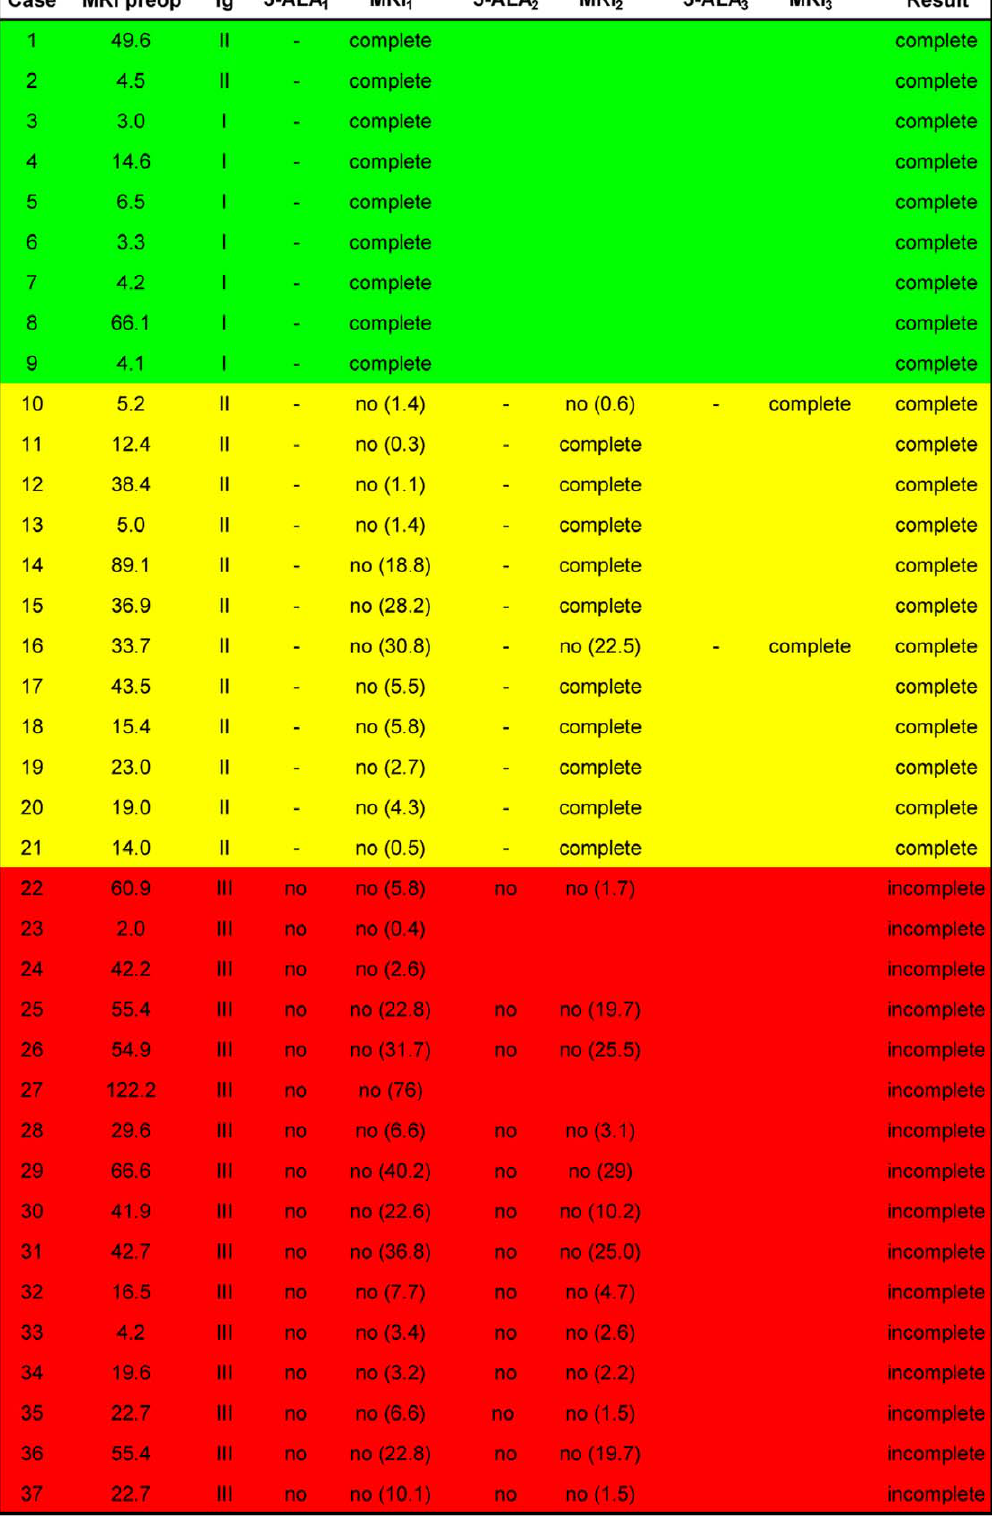
Figure 2. The corresponding surgical data has been given with tumor volume and postoperative outcome. Tumor volume was measured in cm 3 . Functional tumor localization (abbreviated as fg) was determined by preoperative MRI and classified according to Sawaya [20]. Surgery was primarily carried out according to the 5-ALA signal, with corresponding iMRI resection controls carried out following disappearances of this signal. The residual tumor volume following each iMRI scan has been indicated in parentheses. The green color code has been used to depict